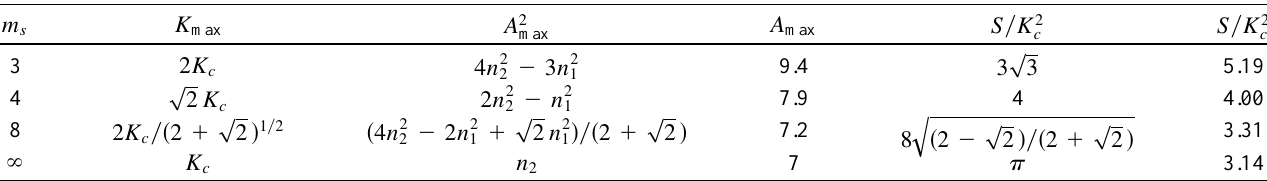
TABLE I. Extension of the secondary halo for different numbers (cid:109) (cid:115) of pairs of secondary jaws per primary impact point. The variable (cid:109) (cid:115) is also the order of the polygon discussed in Sec. IIIB. The expressions for (cid:75) max are obtained by the geometry of regular polygons and the maximum amplitudes are given by (cid:65) (cid:50) (cid:110) (cid:50) (cid:173) (cid:55) to compute (cid:65) max numerically.